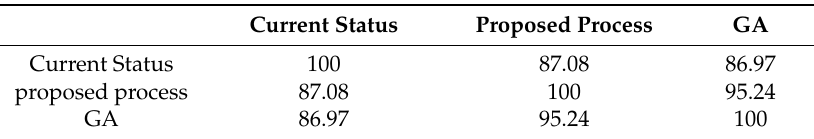
Figure 10. Land-use arrangement overlaps in each iteration with previous iteration result. ( a ) Proposed process. ( b ) GA. Table 8. Overlap percentage of land-use arrangements obtained from proposed process, GA and the current status.